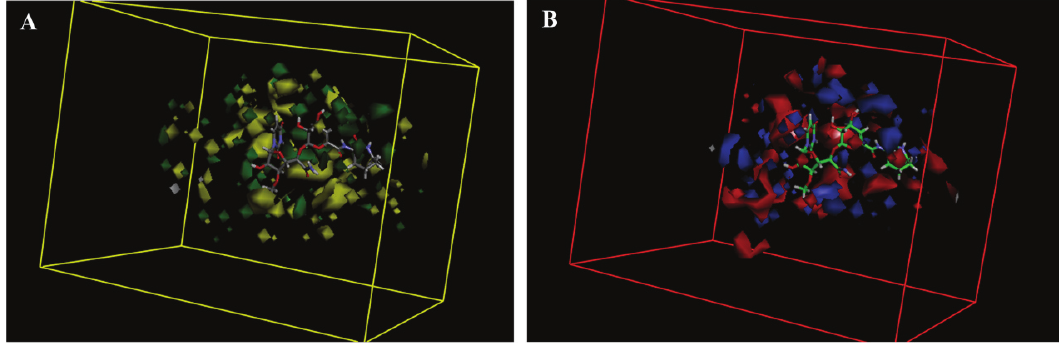
Figure 4: MFA contour maps for steric (A) and electrostatic (B) effects with capuramycin as the reference